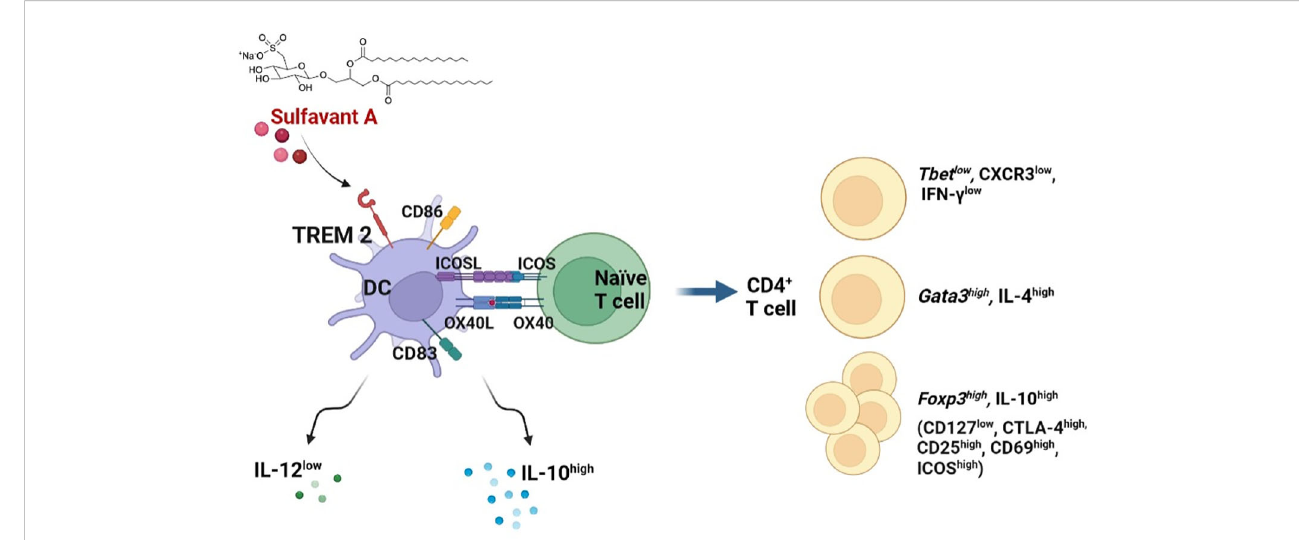
FIGURE 5 Graphic representation of the proposed mechanism of action of SULF A in MLR. After activation of DCs by TREM2, SULF A affects the stimulatory and inhibitory signalling of immune synapse. The glycolipid induces homeostasis restoration by promoting the release of IL-10, reduction of IL-12 and exposure of OX40L and ICOSL on DC membranes. The overall response is a robust T cell stimulation associated to a regulatory mechanism aimed at restoring homeostasis after the allogeneic immune reaction (image created with